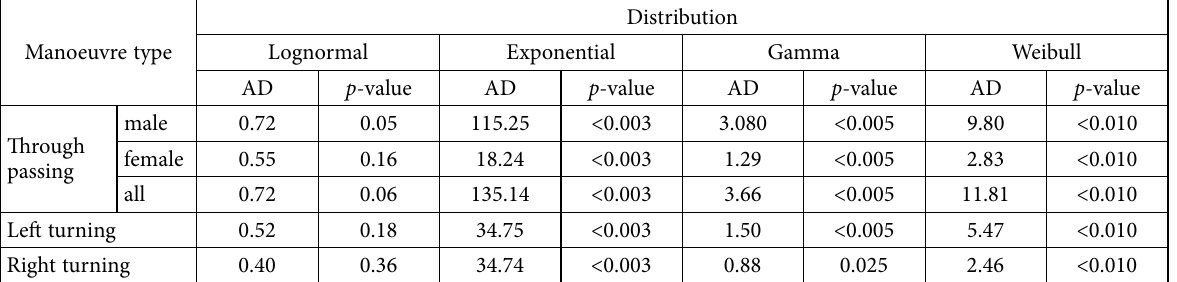
Table 6. Statistical distribution analysis of fit by distribution model